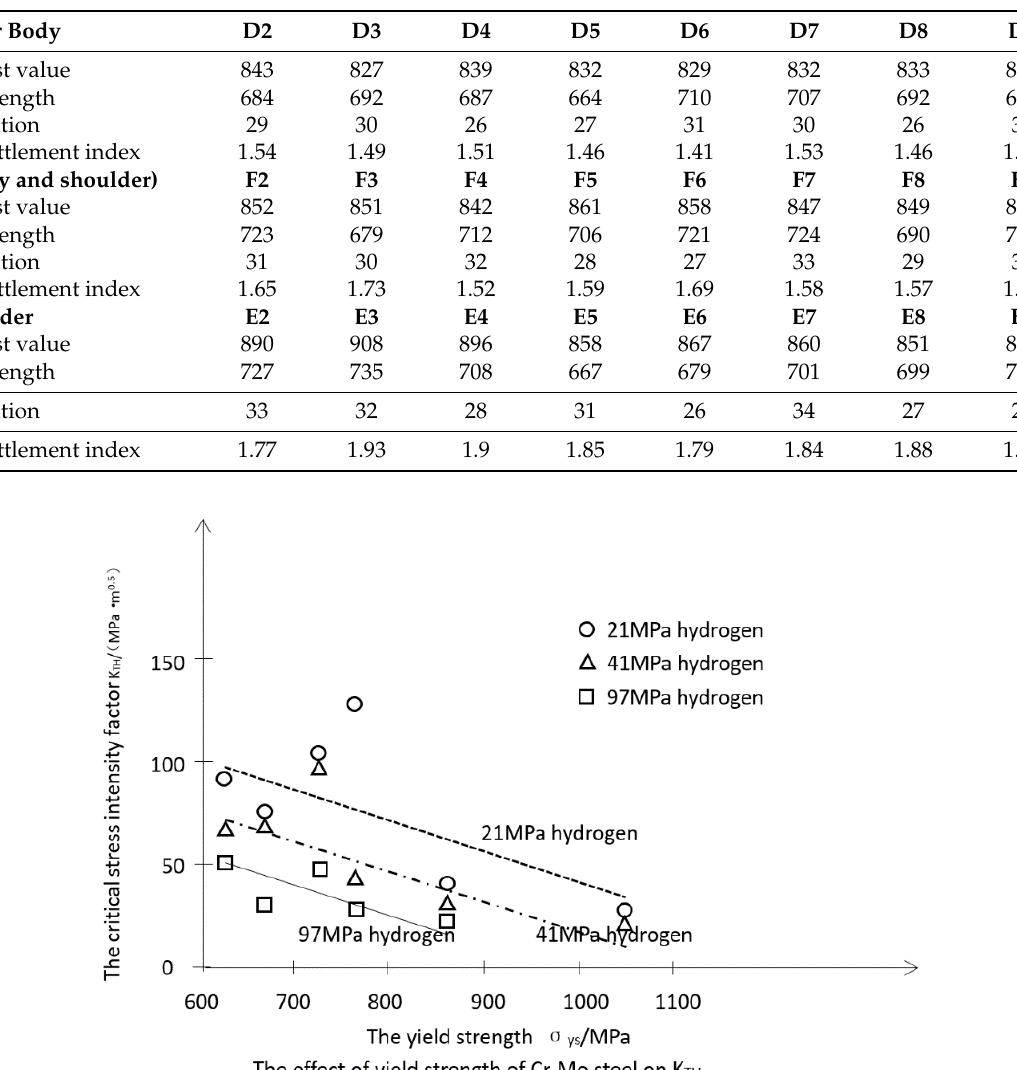
Table 7. The outcome of the tensile test.